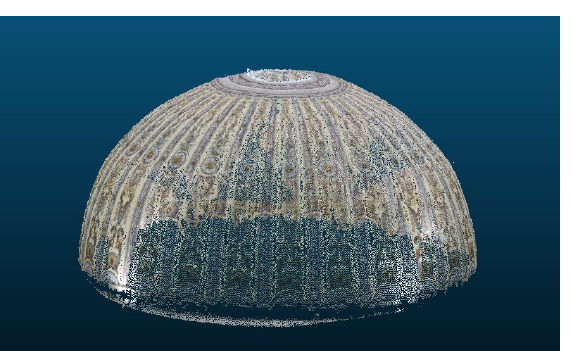
Figure 8: Regard 3D dense point cloud.